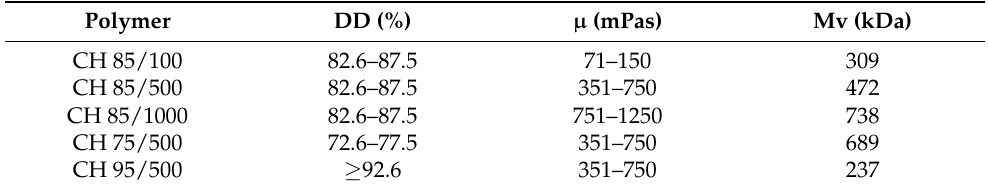
Table 1. Degree of deacetylation (DD), viscosity ( µ ), and viscosity average molecular weight (Mv) of polymers.